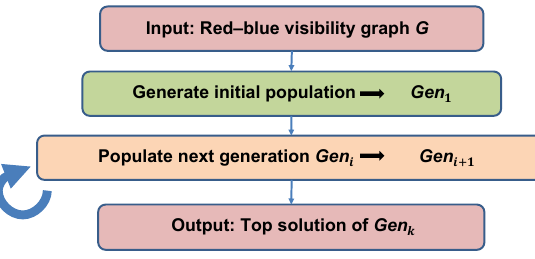
Figure 7. Basic flow of the genetic algorithm